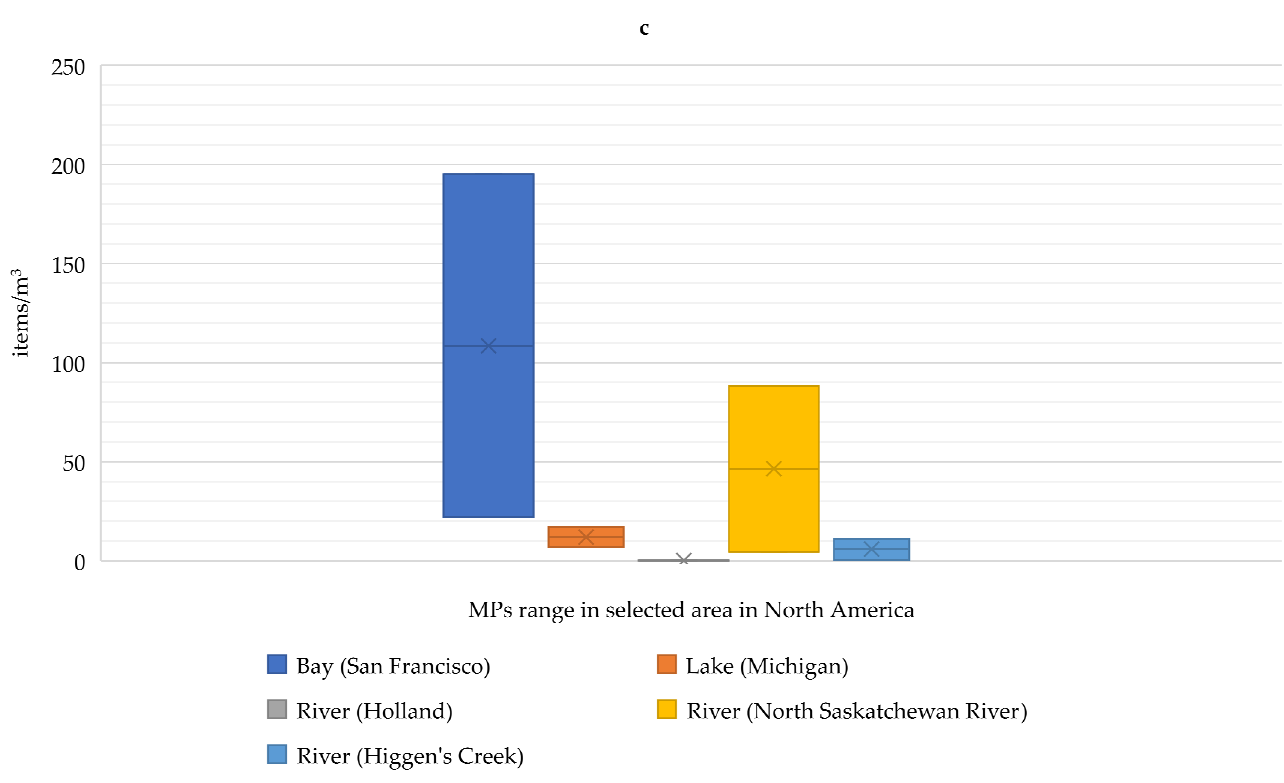
Figure 1. MP range (<5 mm) at selected locations (( a )—Asia; ( b )—Europe; ( c )—North America)